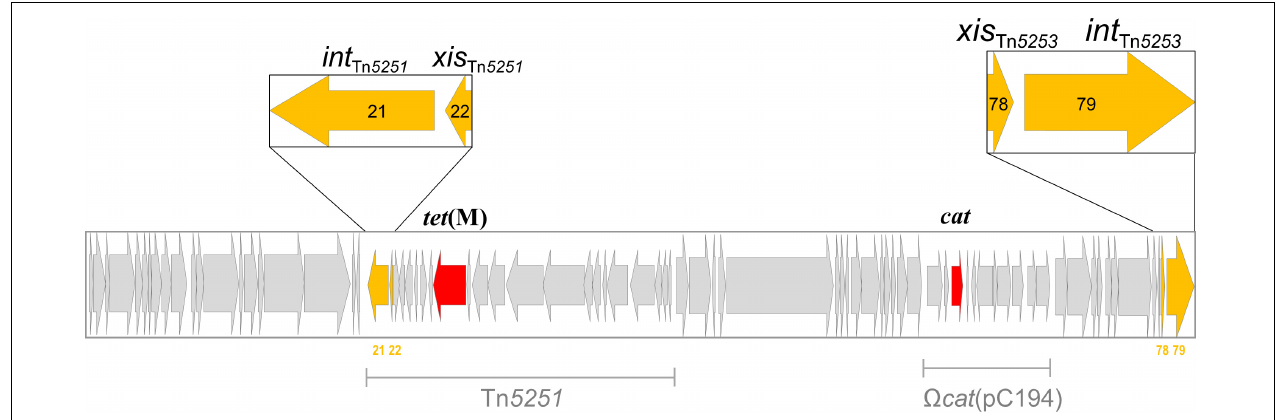
FIGURE 3 | The composite integrative conjugative element (ICE) Tn 5253 contains two distinct genetic elements integrated: (i) Tn 5251 which carries tet (M) and is able to transfer by conjugation autonomously; (ii) (cid:127) cat (pC194) which contains cat, is not conjugative, but is capable of intracellular transposition. Two sets of xis / int recombinase genes are carried by Tn 5253 , one set ( orf78/orf79 ) is at the right end of the element, while the other ( orf21 / orf22 ) belongs to Tn 5251 . ORFs and their transcription direction are indicated as arrows, sequences corresponding to Tn 5251 and (cid:127) cat (pC194) are indicated by solid bars.